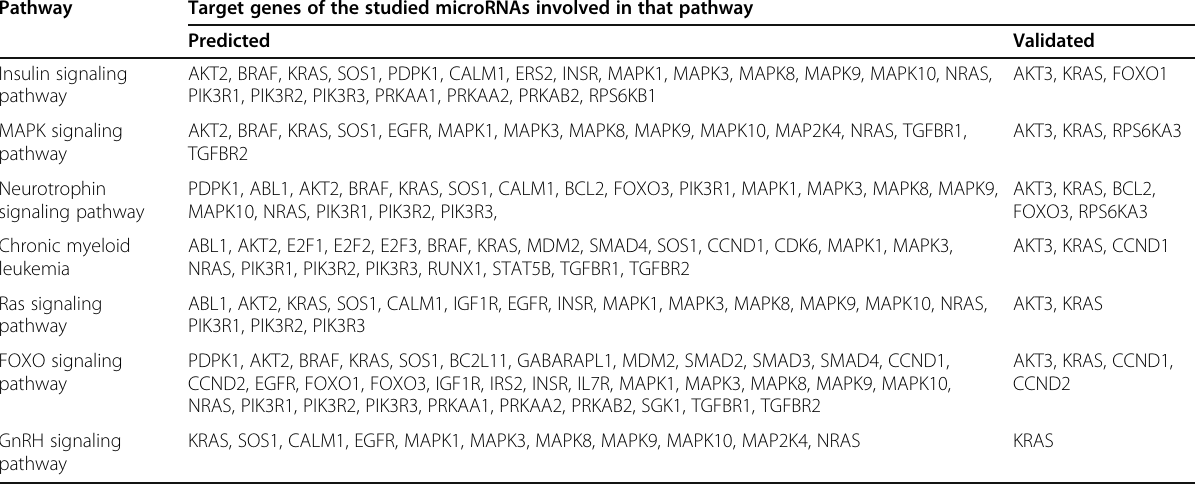
Table 2 Enriched pathways and the involved target genes of the studied miRNAs in each pathway